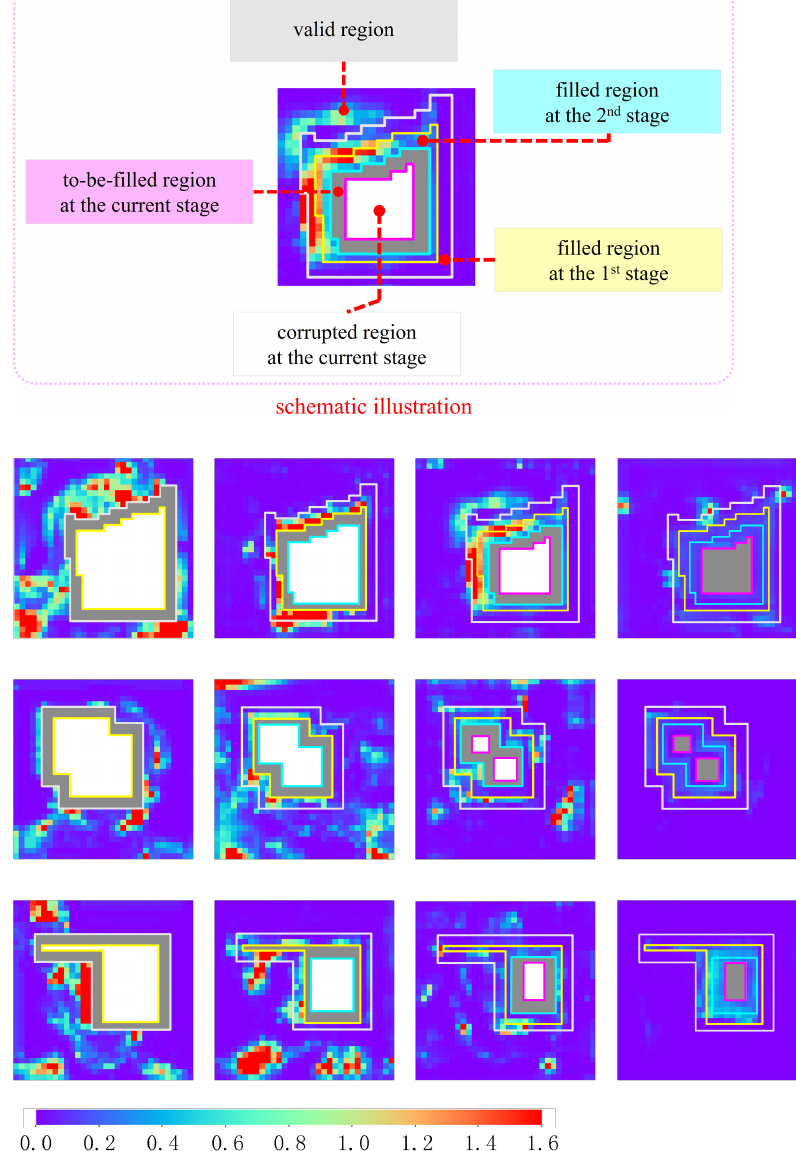
Figure 9. Heat maps of the attention scores. A schematic illustration is shown at the top-half panel, in which four inpainting stages are demarcated by closed-loop frames depicted in colors. Three rows at the bottom-half panel exhibit the heat maps for three practical examples. Four columns, from left to right, correspond to the first, the second, the third and the fourth inpainting stages, respectively. For the first inpainting stage, only the valid region is the source for synthesizing features, and all of the valid patches are likely to contribute to the inpainting task in a learnable way. For the other inpainting stages, the MSCA module borrows the features not only from the valid region but also from the filled ones. As we see in the first